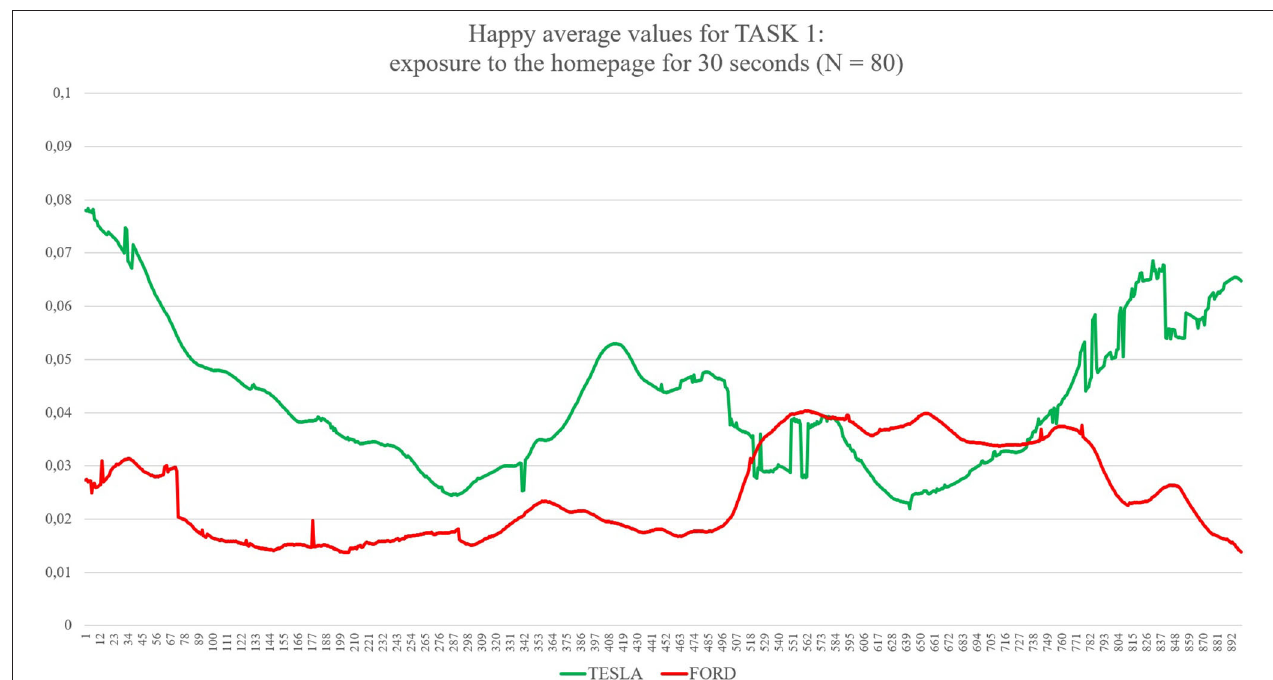
FIGURE 1 | The graph shows continuous values of Happiness for both Ford and Tesla during Task 1 (exploration of the homepage for 30s). The average levels of happiness are higher during the exploration of the Tesla website compared with Ford. On the X axis, time is expressed in 30 samples per second for a total of 900 samples, corresponding to 30s as the total amount of time exposure. On the Y axis, values of happiness are expressed between 0 (no happiness expressed by the face) and 1 (highest intensity of happiness expressed by the face).